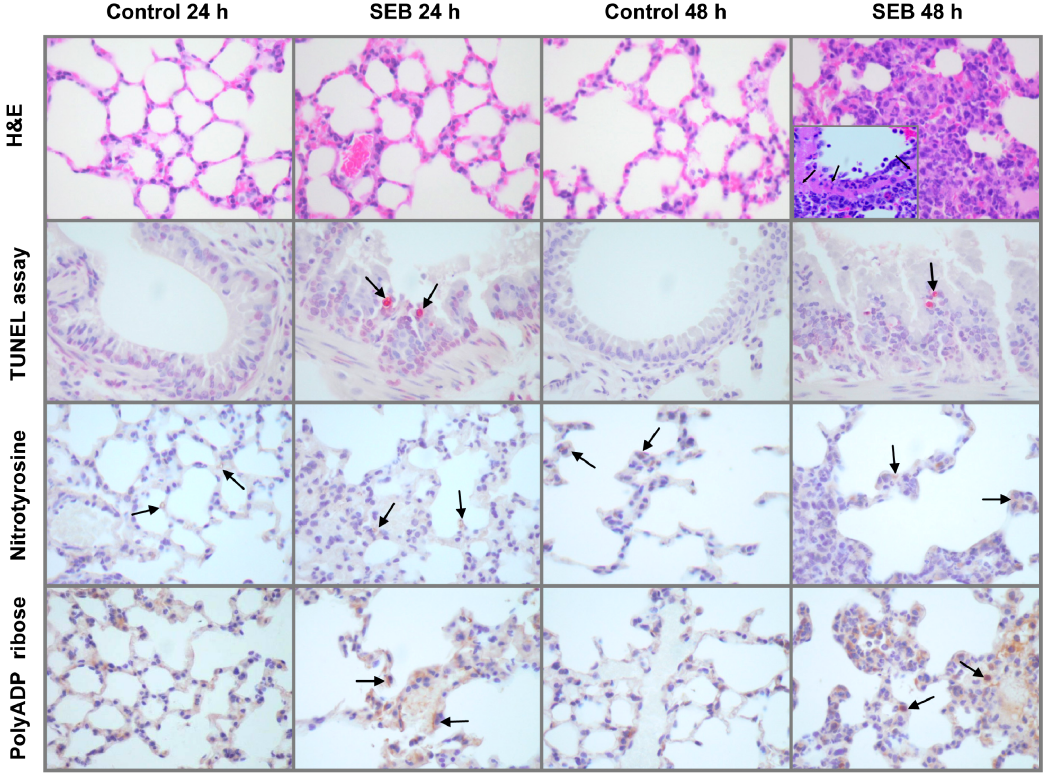
Figure 7. Pulmonary pathology: hematoxylin and eosin (H&E) stain, TUNEL assay and immunohistochemistry staining for nitrotyrosine and polyADP-ribose. Compared to control animals at 24 h, staphylococcal enterotoxin B (SEB) challenge caused a multifocal, minimal to mild perivascular, peribronchiolar, interstitial and subpleural lymphohistiocytic inflammatory infiltrate. At 48 h a coalescing, neutrophil- predominant infiltrate was seen in SEB exposed animals that now extended into alveoli. Multiple vessel walls 48 h after SEB exposure contained neutrophilic fragments (arrows) consistent with vasculitis (H&E inset, SEB 48 h). Terminal deoxynucleotidyl transferase-mediated dUTP nick end labeling (TUNEL) assay demonstrated an increase in bronchiolar apoptotic cells (arrows) after SEB challenge compared to control that was significant at 24 h post-exposure (2.93 6 0.12 versus 0.06 6 0.06 cells/HPF; p , 0.001 ). Immunohistochemistry for nitrotyrosine was not different comparing SEB to control with all specimens showing faint staining (arrows) of alveolar epithelium, small vessel endothelium and alveolar macrophages. In contrast, immunohistochemistry for polyADP-ribose (PAR) showed increased staining associated with SEB exposure that was mostly proportional to the increase in inflammatory cellularity. At 48 h, hypertrophied alveolar epithelial cells (arrows) stained prominently for PAR.